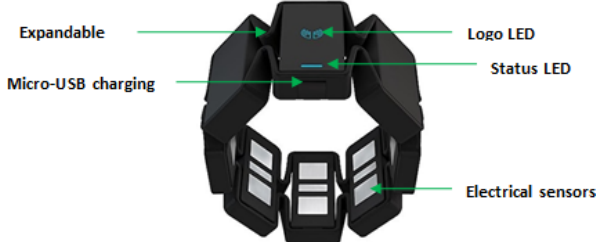
Figure 10. Set of Myo